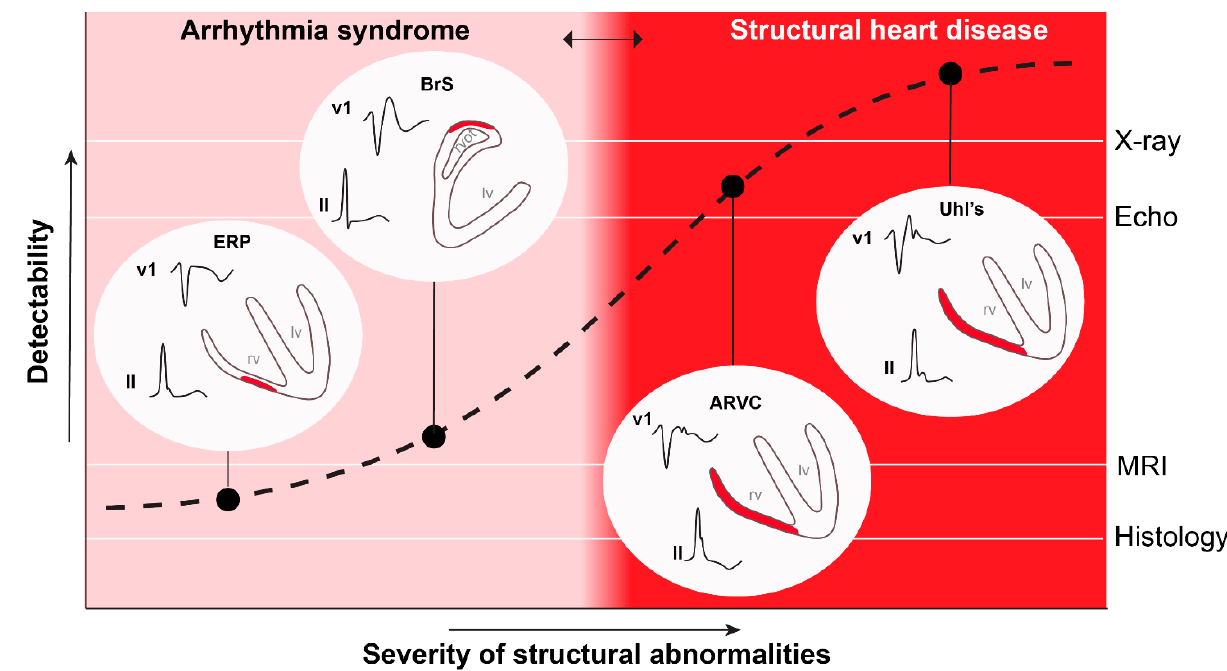
Figure 4. The definition of structural heart disease is based on the ability to detect structural abnormalities. An increased spatial resolution of the detection technique will lead to a leftward shift of the red zone. ERP, early repolarization pattern; BrS, Brugada syndrome; ARVC, arrhythmogenic right ventricular cardiomyopathy; Uhl’s, Uhl’s disease; MRI, magnetic resonance imaging; Echo, echocardiography. This figure was used with permission from [54].